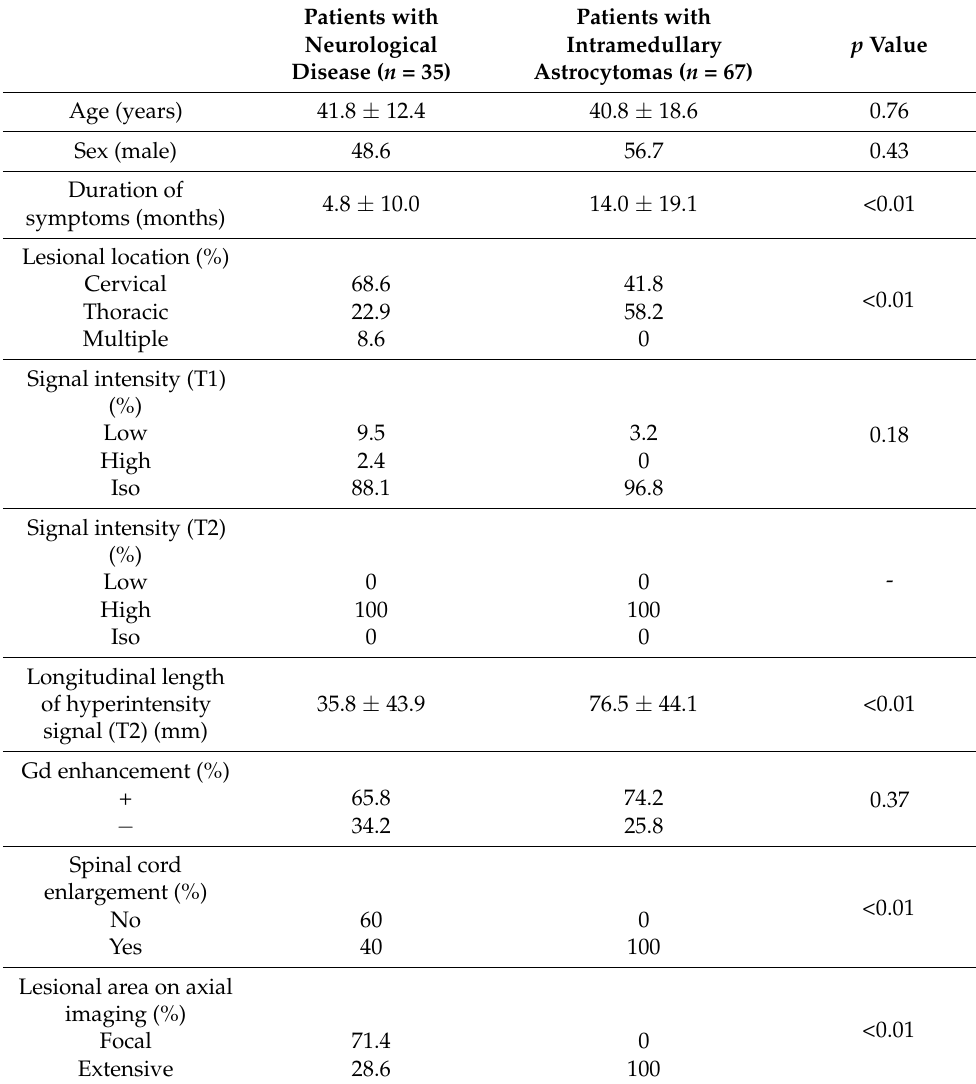
Table 3. Clinical characteristics and MRI findings between patients with neurological diseases and those with intramedullary astrocytomas. Patients with Patients with p Value Intramedullary Neurological Astrocytomas ( n = 67) Disease ( n = 35) Age (years) 41.8 ± 12.4 40.8 ± 18.6 0.76 48.6 56.7 0.43 Duration of 4.8 ± symptoms (months)